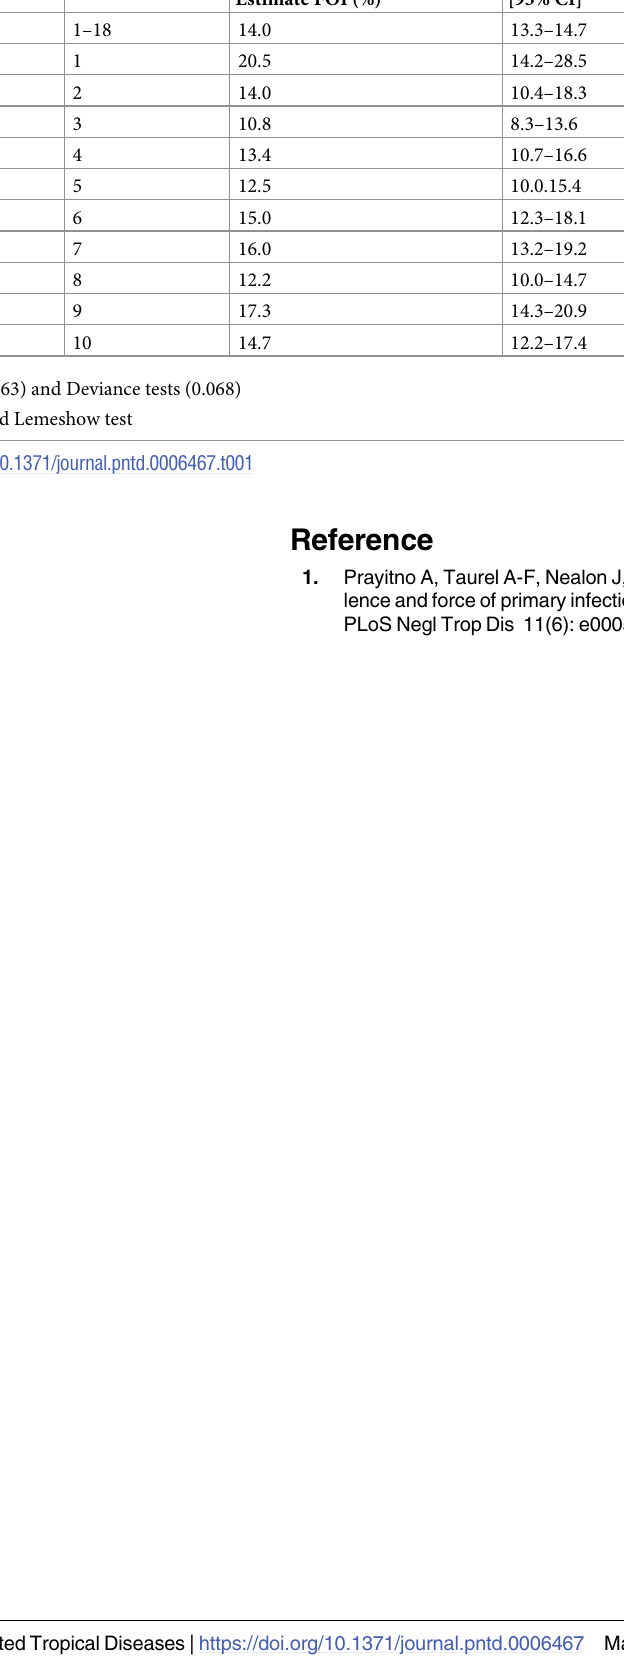
Table 3. Dengue virus force of infection time varying and constant risk model.